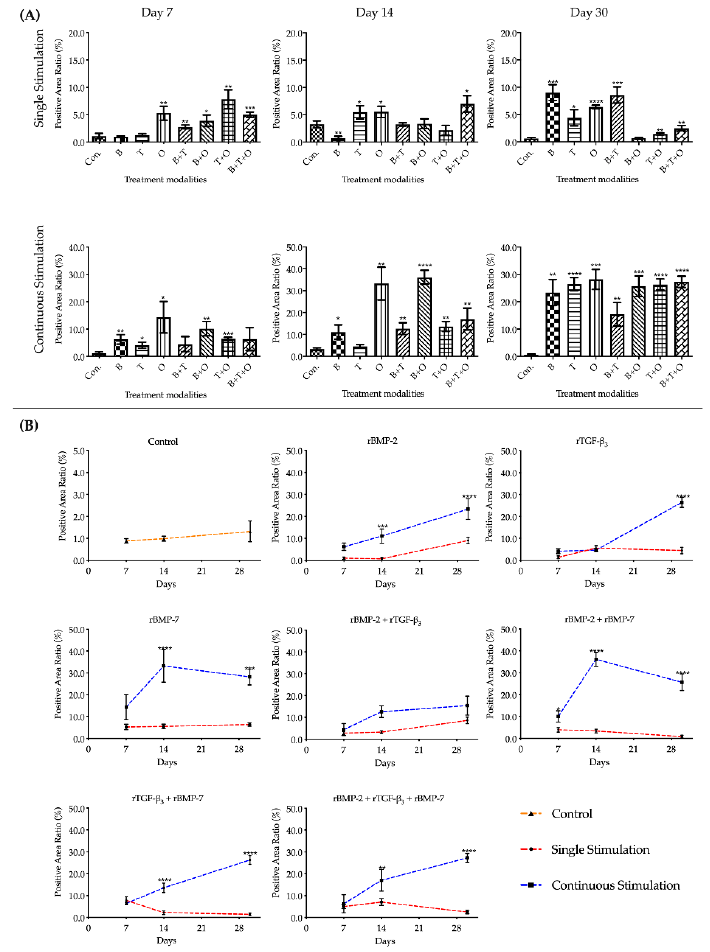
Figure 8. The semi-quantitative histomorphometrical analysis of alcian blue staining. The results were presented as positive area ratio (%). ( A ) Comparisons between each experimental group under different stimulation modes and the corresponding control group at day 7, 14 and 30 using one-way ANOVA. ( B ) Comparisons between the experimental groups where growth factors were applied continuously and the corresponding 48 h withdrawal groups at day 7, 14 and 30 using two-way ANOVA. Con. = control group, B= rBMP-2 treated group, T= rTGF- β 3 treated group, O = rBMP-7 treated group, B + T = rBMP-2 + rTGF- β 3 treated group, B + O = rBMP-2 + rBMP-7 treated group, T + O= rTGF- β 3 + rBMP-7 treated group, B + T + O= rBMP-2 + rTGF- β 3 + rBMP-7 treated group. Number of replicates ( n ) = 6. We defined p < 0.05 as a statistically significant difference. * p < 0.05, ** p < 0.01, *** p < 0.001, **** p < 0.0001. In ( A ) statistical